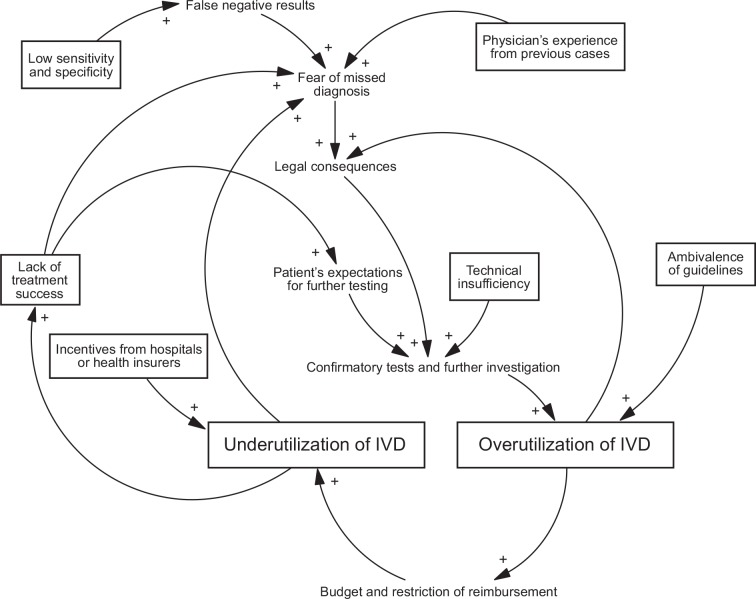
Causal loop diagram displaying the root causes for over- and under-utilization of IVD testing. Key drivers displayed in boxes; antecedents and secondary drivers displayed as plain text.IVD, in vitro diagnostic; →(+), positive causal links amplifying the behavior of target variable.